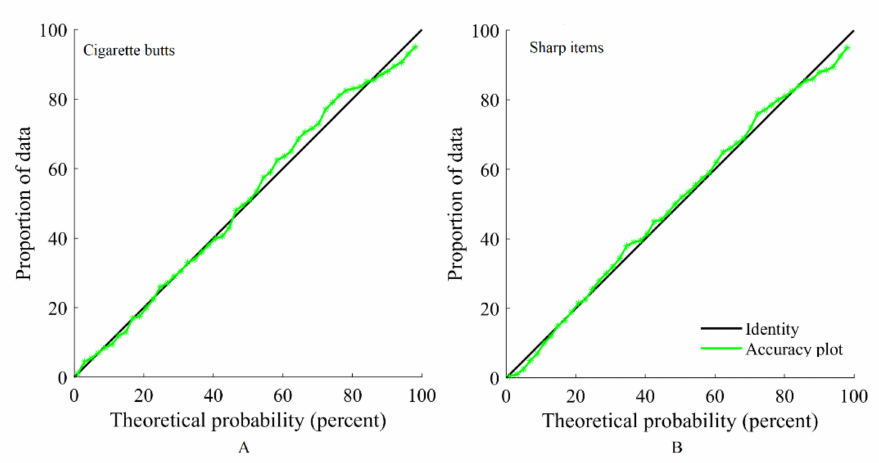
Figure 12. Accuracy plots for ( A ) cigarette butts, and ( B ) sharp